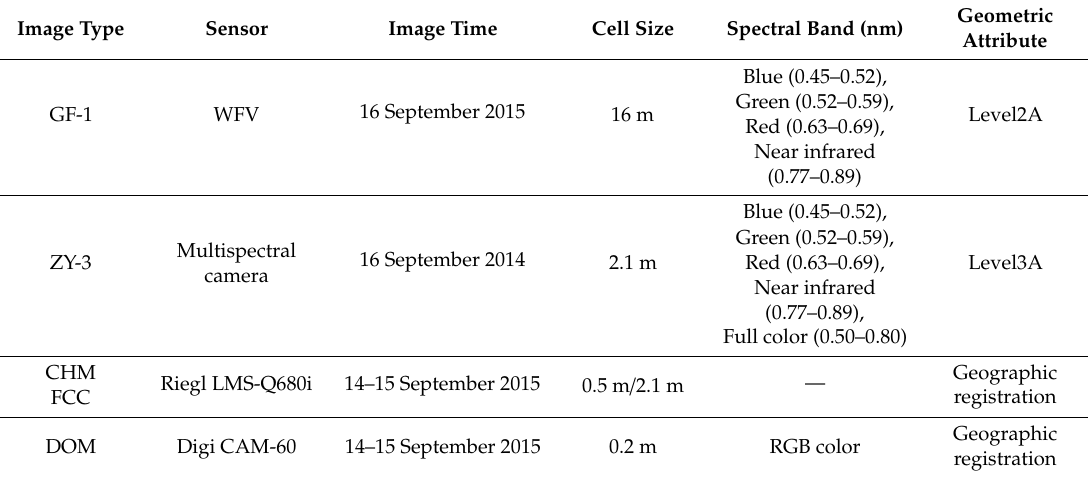
Table 1. Multi-source remote sensing image dataset for vegetation type